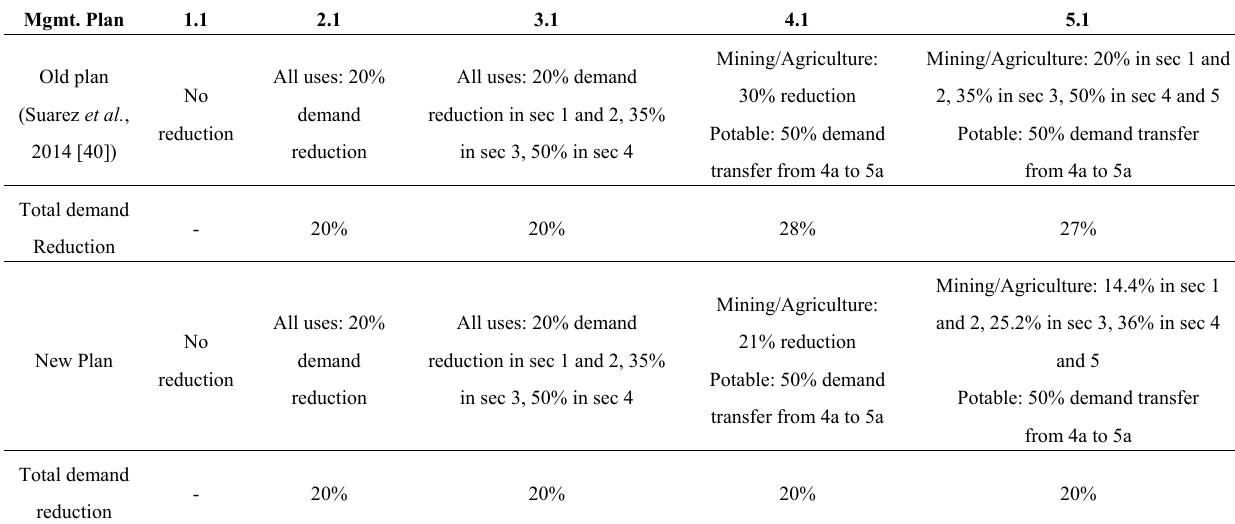
Table 8. Management schemes, original and adjusted for equal demand reduction (“sec” refers to administrative sectors, see Figure 4).